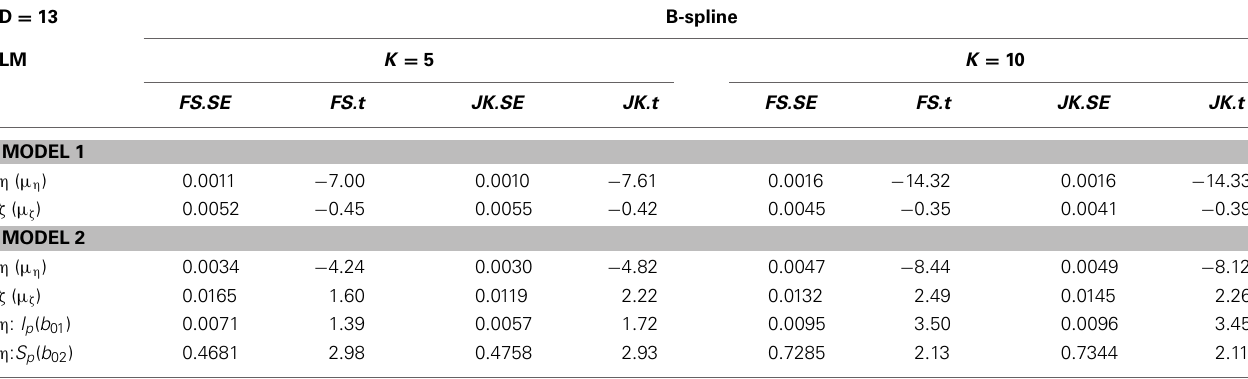
Table 4 | Results for the full sample ( N = 112) and jackknife sample, with number of knots K = 5 and dimension D = 13. D = 13